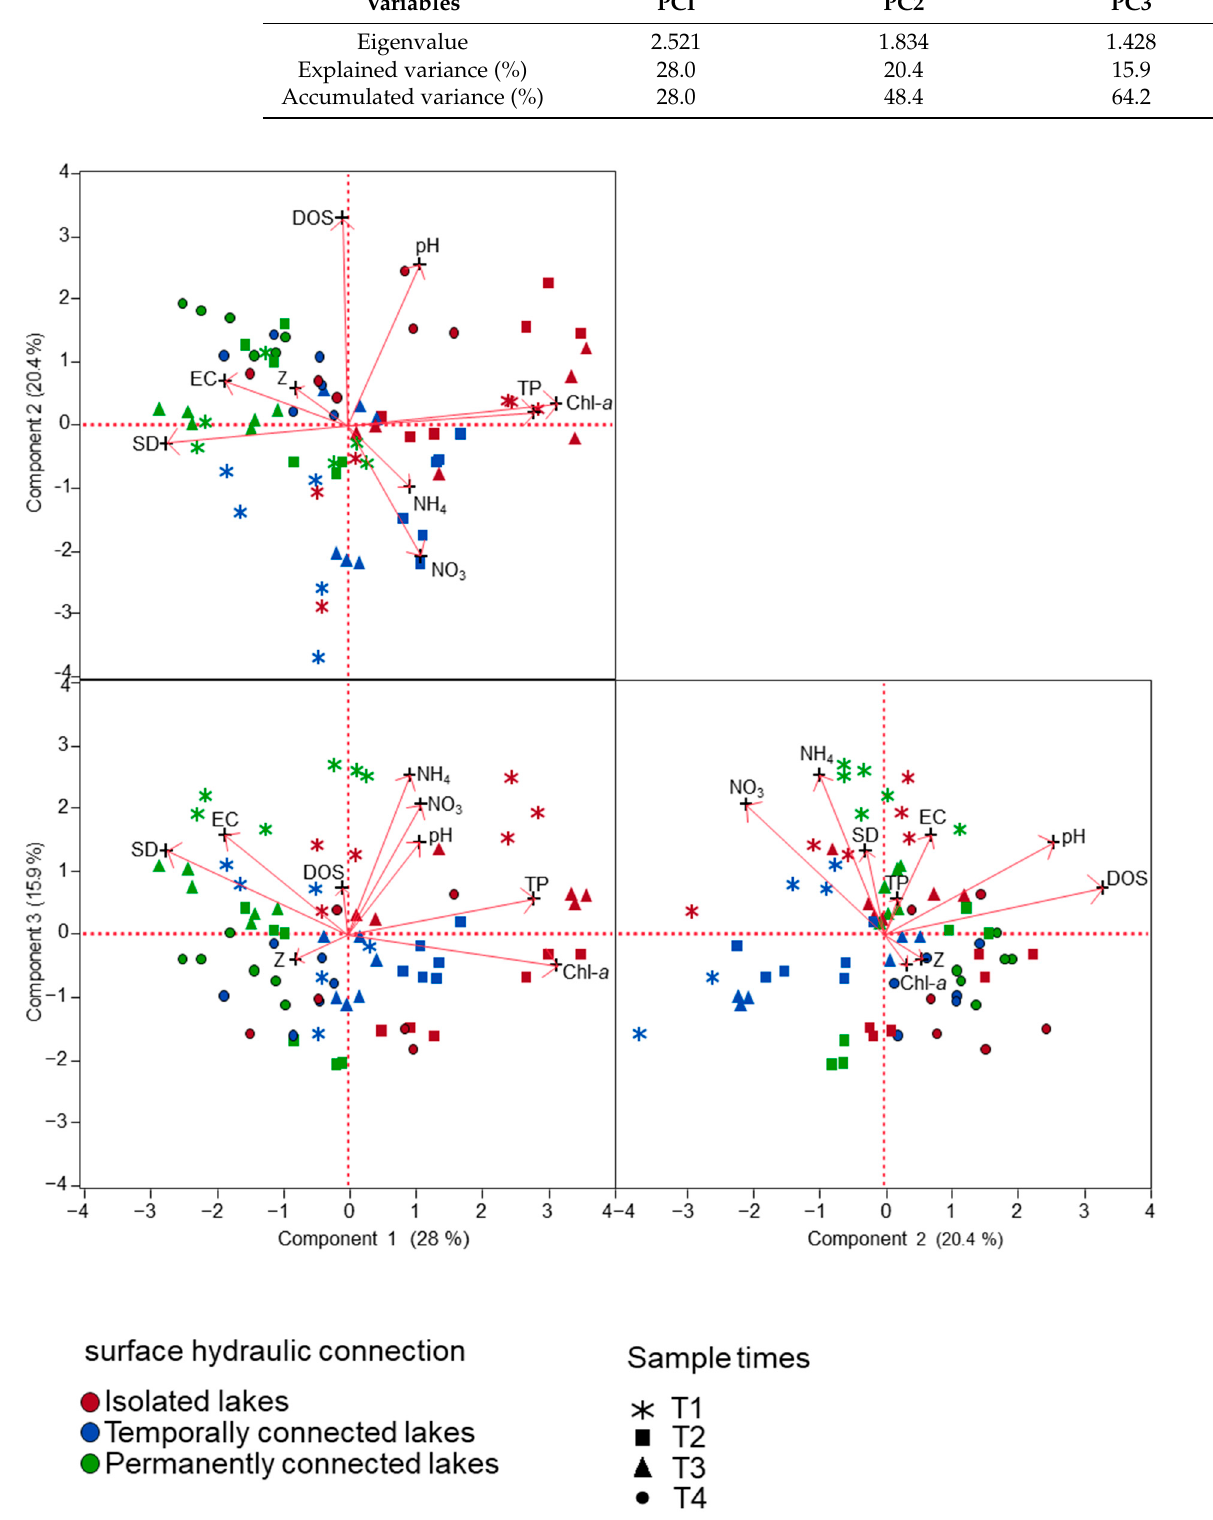
Figure 4. Biplot of the PCA (variables and scores) for water level (WL), Secchi disk (SD), dissolved oxygen saturation (DOS), hydrogen potential (pH), electrical conductivity (EC), ammonium (NH 4 + ), nitrates (NO 3 - ), total phosphorus (TP), and chlorophyll- a (Chl- a ). Table 2. Loadings, eigenvalues, and PCA variance. Loadings greater than |0.4| and eigenvalues greater than 1 in each PC are in bold. WL = water level, SD = Secchi disk depth, DOS = dissolved oxygen saturation, pH = hydrogen potential, EC = electrical conductivity, NH 4+ = ammonium, NO 3 − = nitrate, TP = total phosphorus, Chl- a = chlorophyll- a . n = 648. Variables